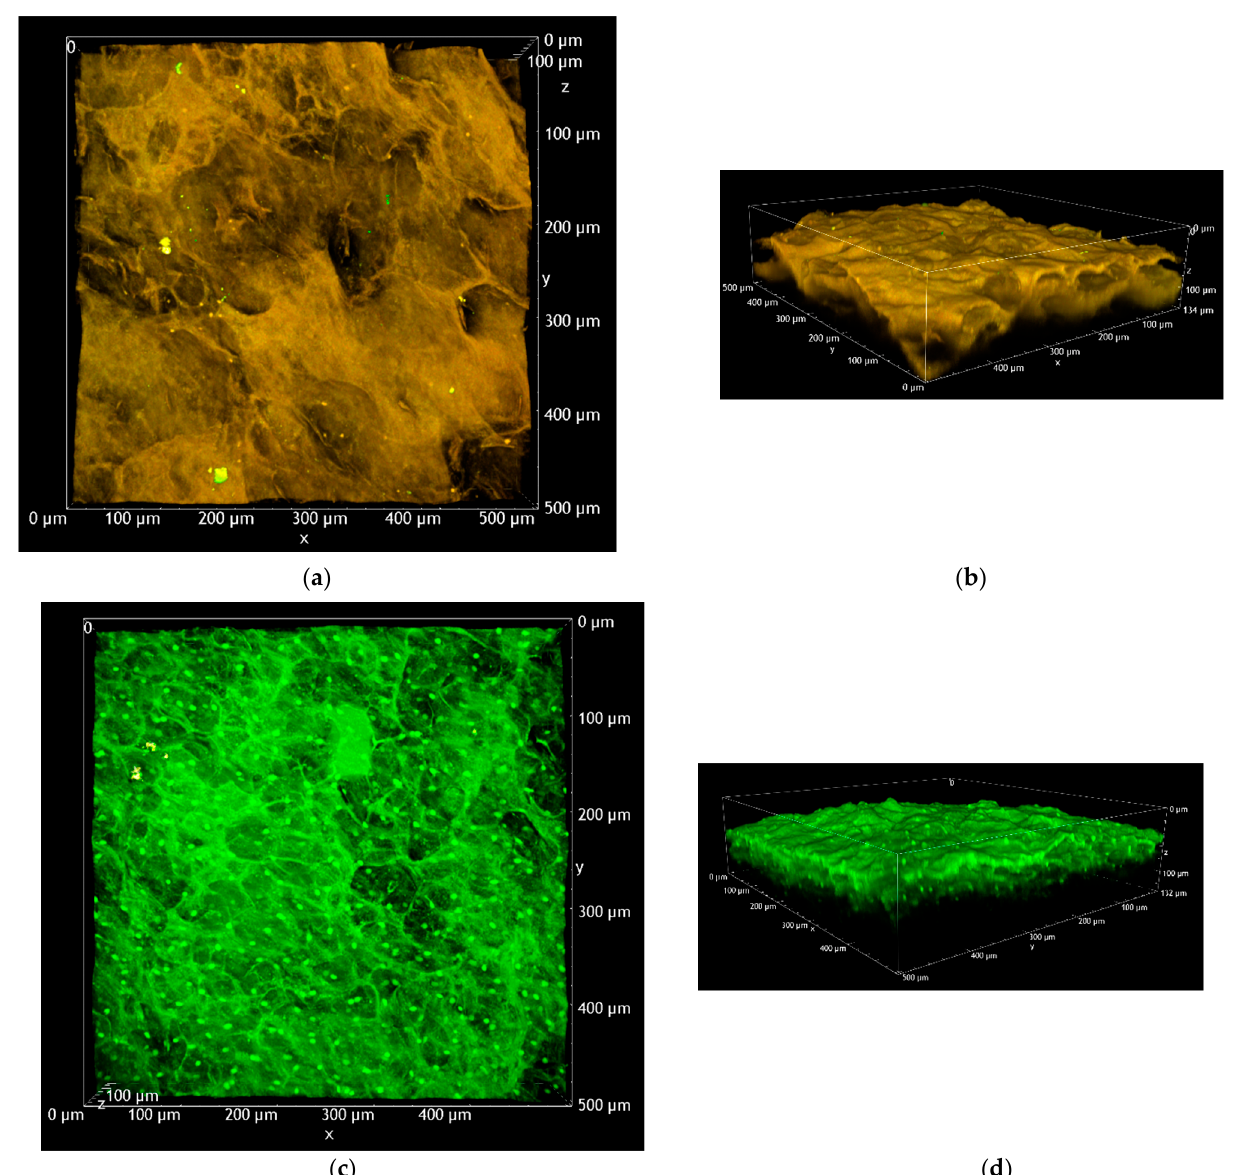
11 of 15 ( c ) Figure 5. ( a , b ): TPEF images (image size: 500 × 500 µm) acquired at an intermediate depth (~70 µm from the surface) with an excitation wavelength of 1030 nm from the blank and treated with caprylic acid (C8) tissues, respectively; ( c ) comparison between the normalized emission spectra of an FD- 70 aqueous solution and the blank and treated tissues (excited at 1030 nm and recorded in corre- spondence with the ( a , b ) focal plane). Arrows in panels a and b display epithelial cell nuclei.